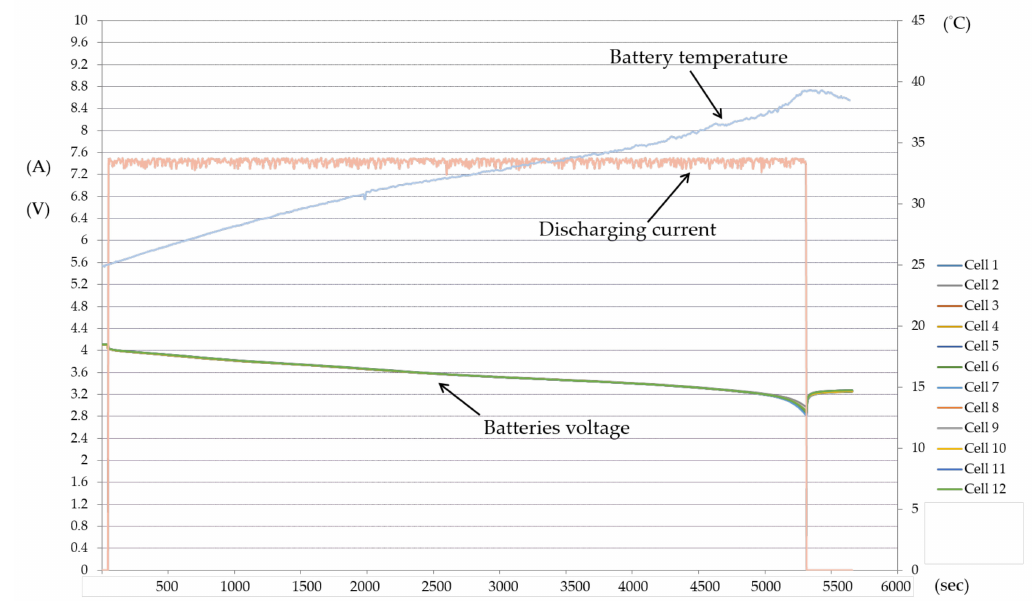
Figure 17. Over-discharge protection of the lithium-ion battery